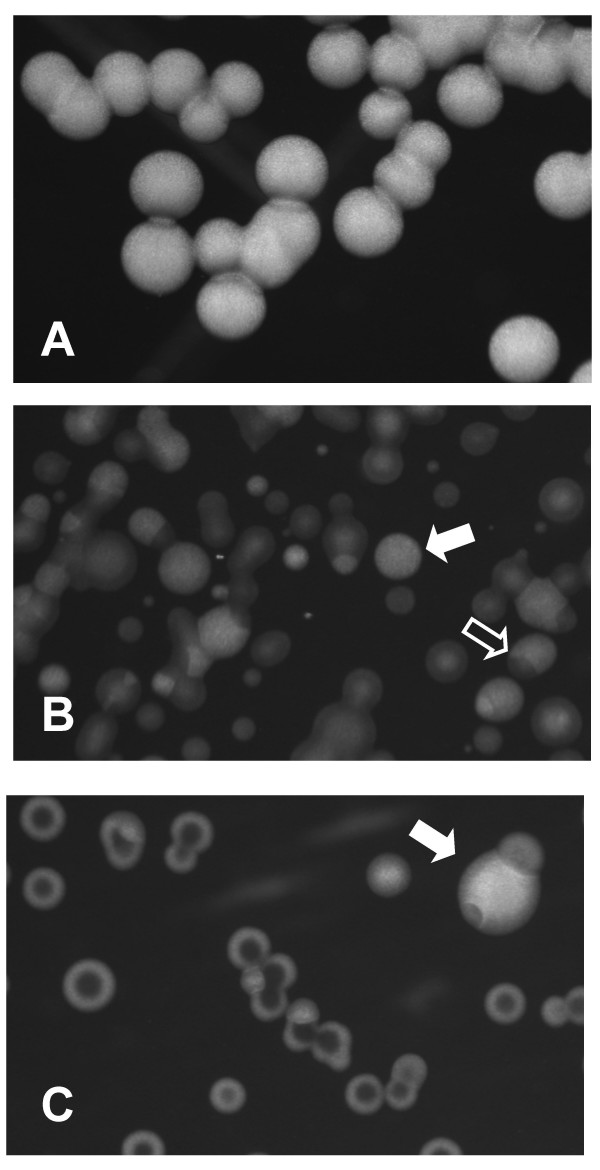
Pneumococcal colonies exhibiting the various opacity phenotypes. A) Serotype 12B displaying the opaque phenotype. B) Serotype 14 displaying a mixture of opacity phenotypes. Most colonies are transparent, white arrow indicates an opaque colony, open arrow indicates a sectored colony. C) Serotype 8 displaying mostly transparent colonies. White arrow indicates an opaque sectored colony.